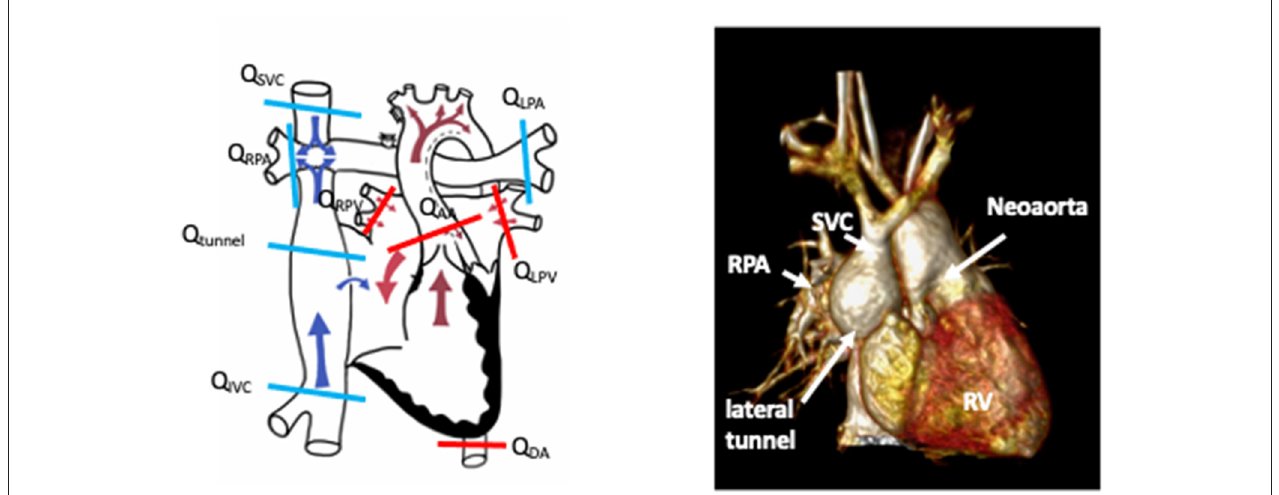
FIGURE 7 | Schematic demonstrating sites of flow measurement in a lateral tunnel Fontan circulation by phase contrast CMR to facilitate shunt calculations. Schematic drawing courtesy of Dr. Aaron Bell, Evelina London Children’s Hospital. The accompanying figure is a rendered 3D whole-heart image of a patient with a Fontan circulation for hypoplastic left heart syndrome. SVC, superior vena cava; RPA, right pulmonary artery; RV, systemic right